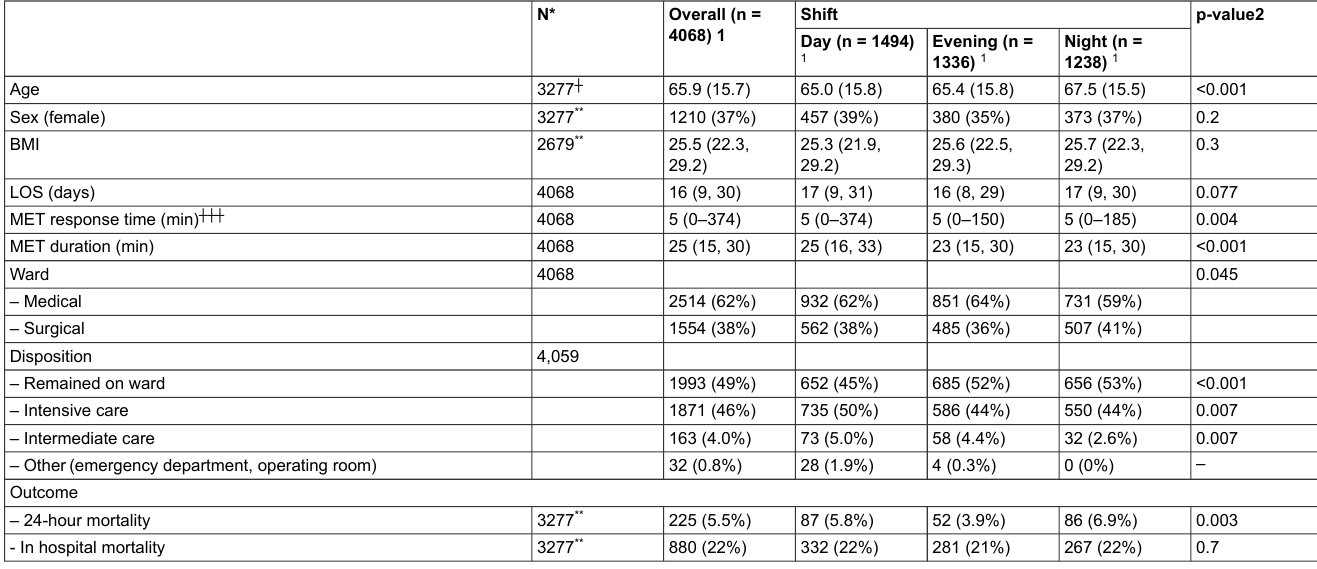
Table 1: Baselines and outcomes according to nursing